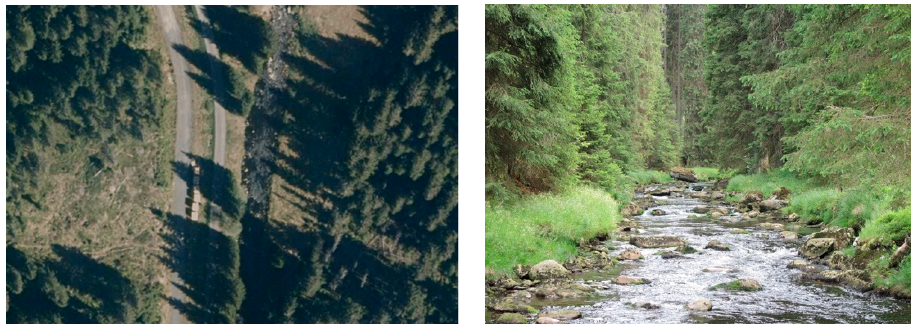
Figure A7. Aerial photo and photo of class C2.